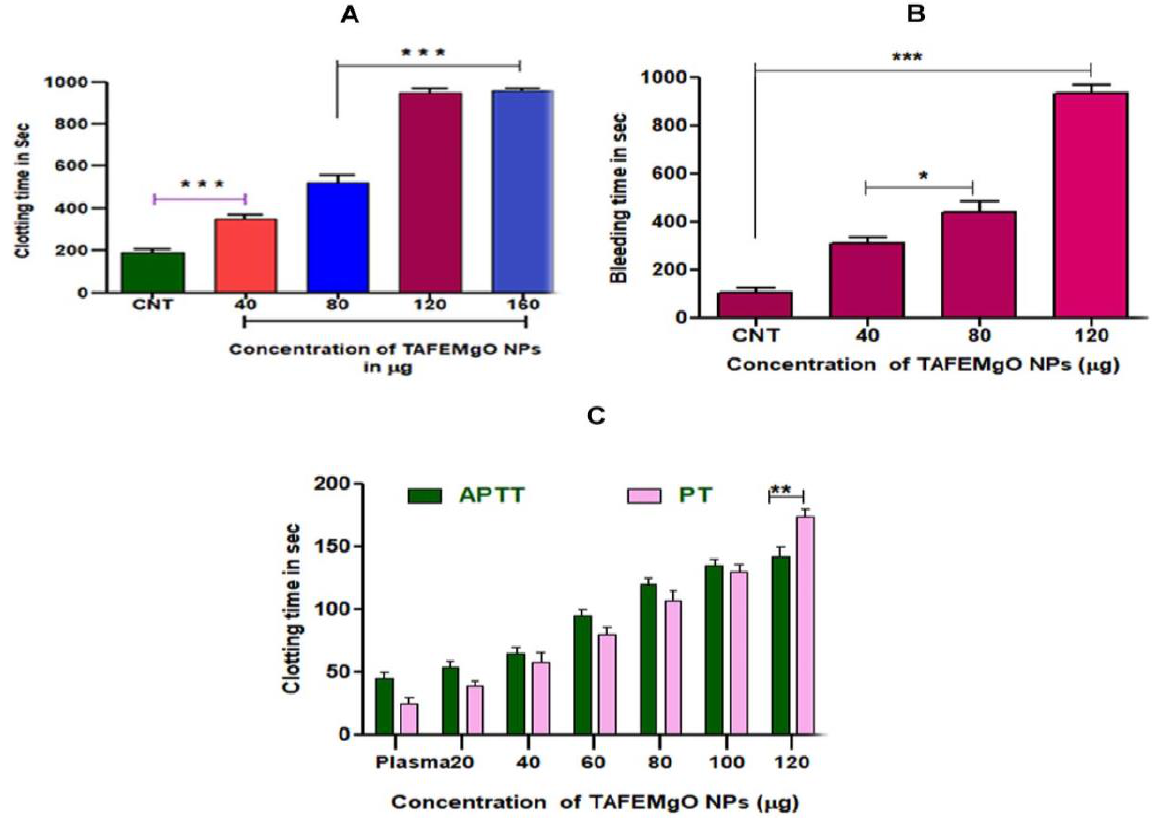
Figure 7. ( A ) Plasma recalcification time of TAFEMgO NPs: CNT-control clotting time was in- creased with TAFEMgO NPs in a dose-dependent (20 – 100 μ g) manner. ( B ) Tail-bleeding time of MgO NPs: intravenous injection of TAFEMgO NPs to experimental rats caused dose-dependent increase in bleeding time with CNT (control). ( C ) Concentration-dependent effect of TAFEMgO NPs on the activated PT (prothrombin time) and the APTT (activated partial thromboplastin time). * Significance at p 0.005, ** at p 0.001 and *** at p 0.0001.